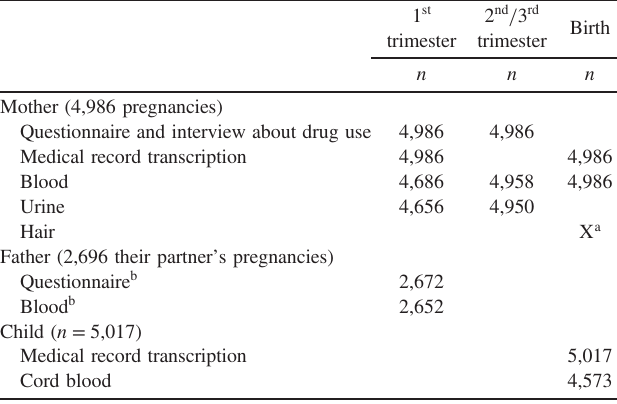
Table 1. Numbers of mothers, fathers, and children